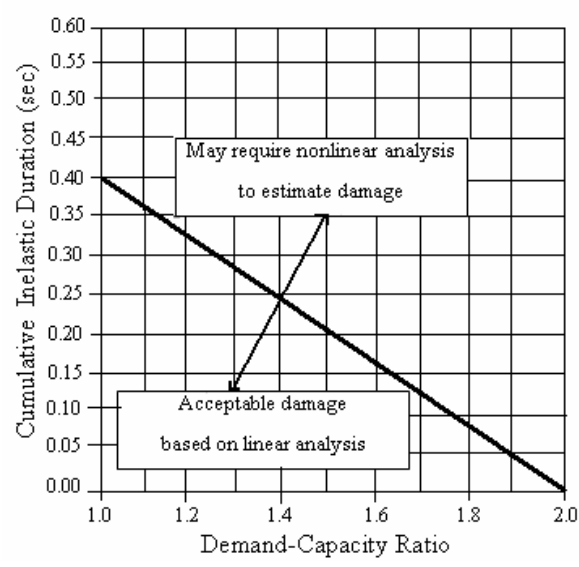
Fig.1. Performance curve for linear elastic analysis of arch dams (Ghanaat, 2002; USACE, Fig. 1. Performance curve for linear elastic analysis of arch dams 2003). (Ghanaat, 2002; USACE,